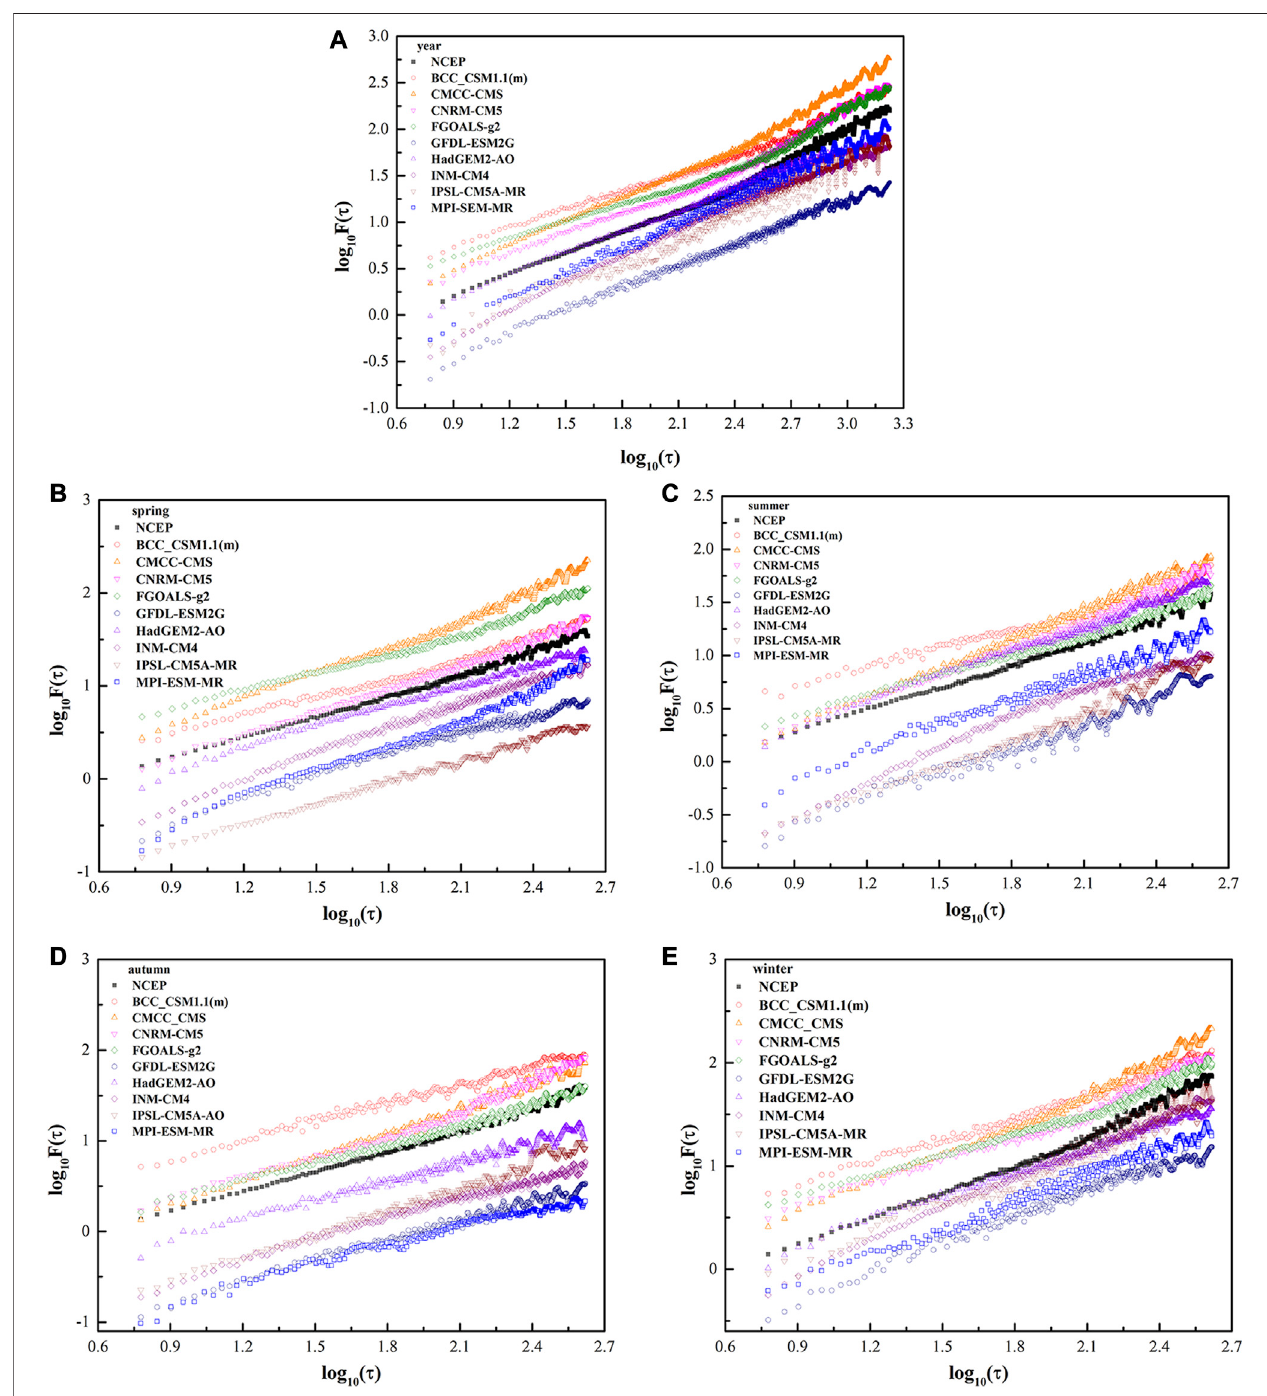
FIGURE3| TheDFA2exponentsofdailyprecipitationobtainedfromNCEPandCMIP5modelsat (A) pointof(110 ° W,35 ° N), (B) pointof(175 ° W,0 ° )foryearandall four seasons.